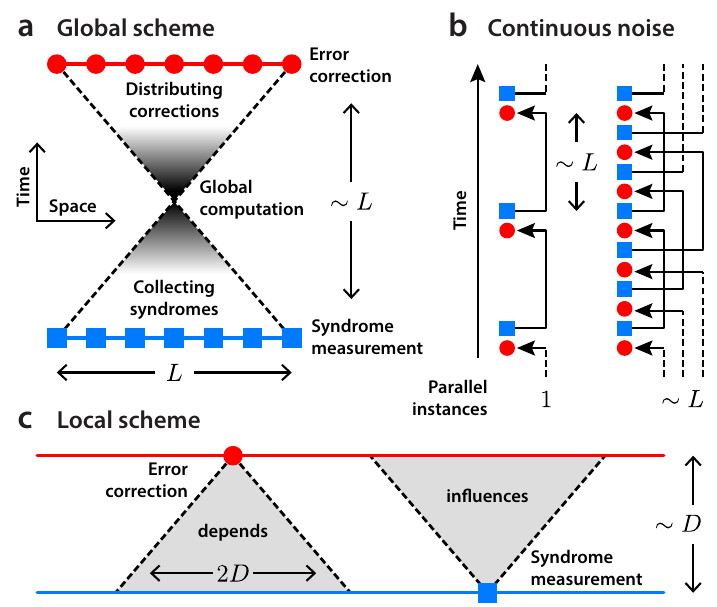
Figure 2: Locality constraints. a A global correction scheme on a quantum code of linear size L requires the syndrome data to be merged, processed, and afterwards the results to be distributed again. The finite communication speed makes the time between syndrome measurements (blue squares) and error corrections (red circles) scale with L in the best